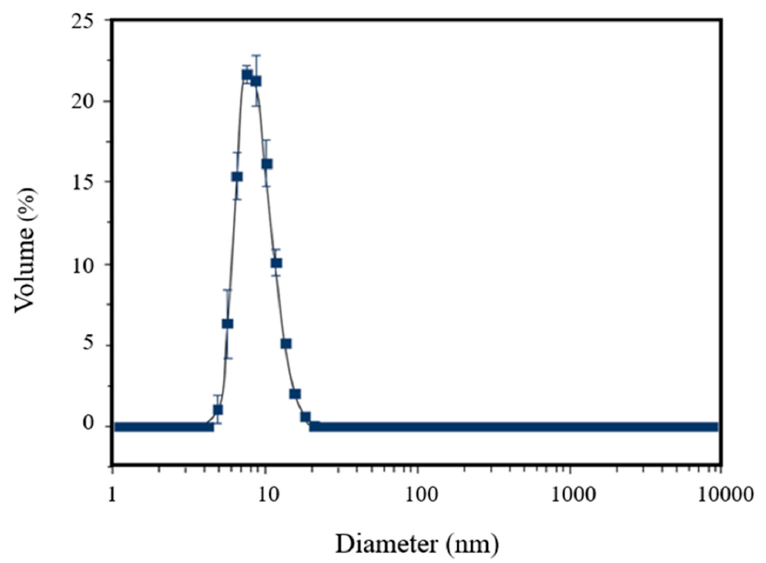
Figure 2. Dynamic light scattering analysis of [ 198 Au]AuNPs, showing a mean size of 13 nm and a PDI of 0.106 ( ± 0.089).